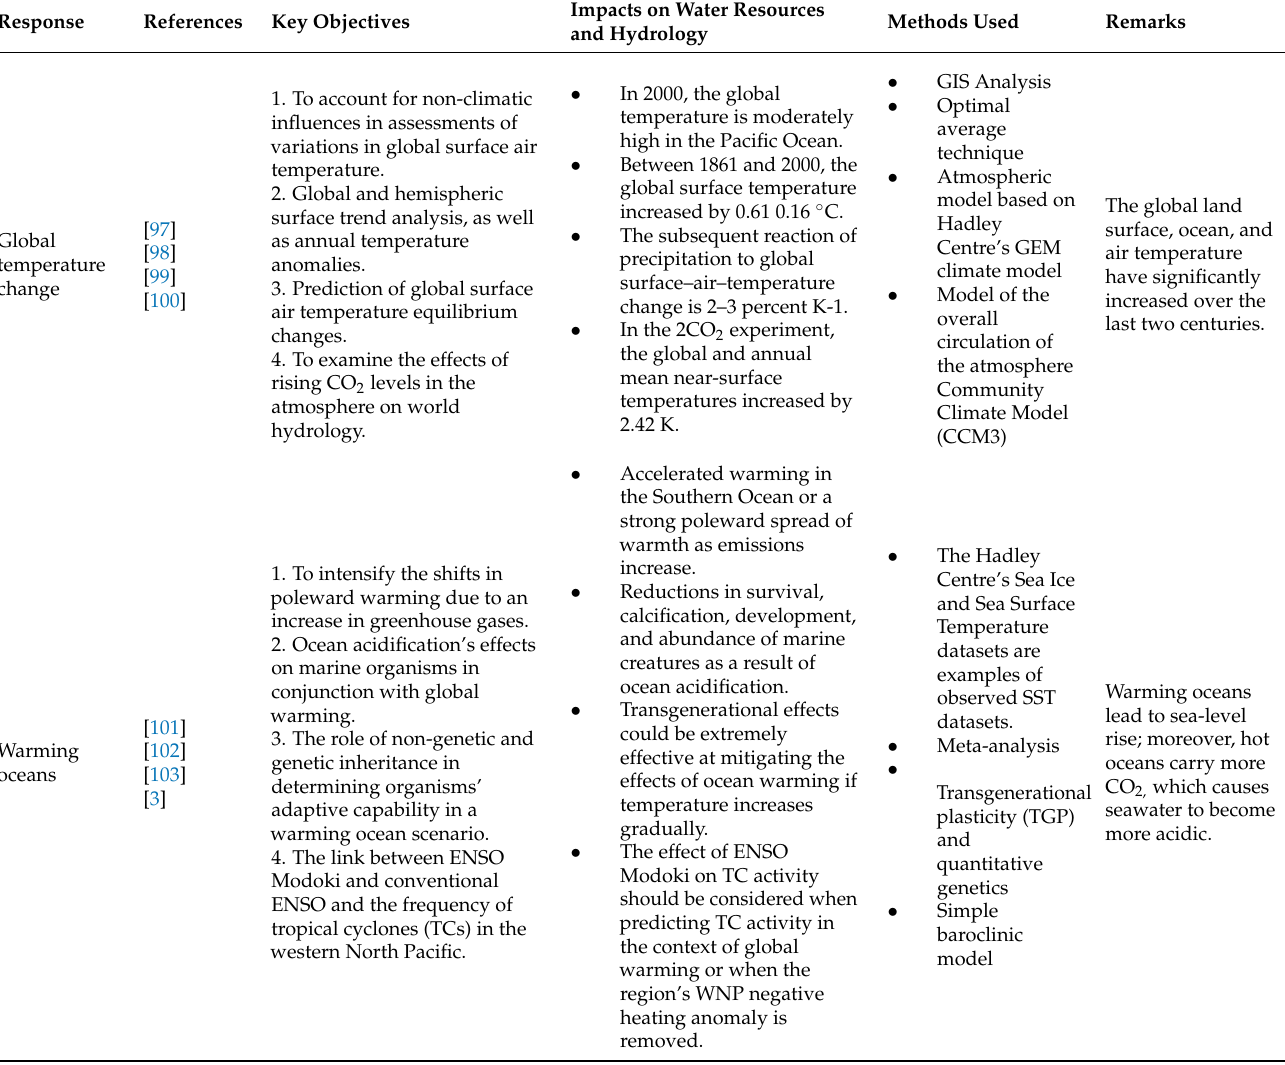
Table 4. State-of-the-art research on climate variability and subsequent effects on water